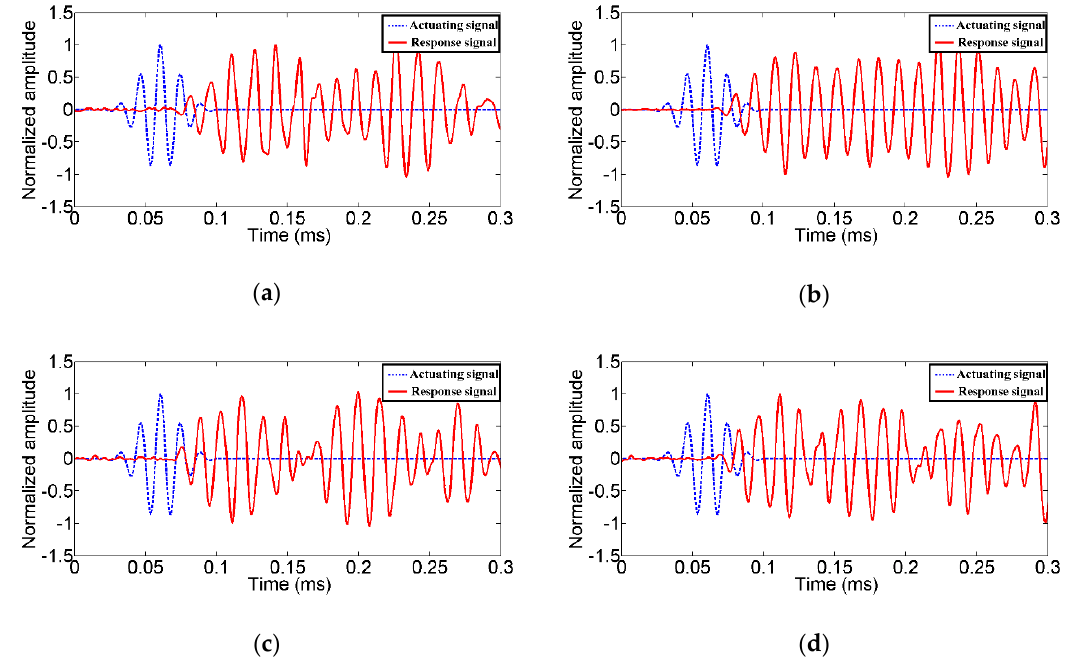
Figure 9. The time of arrival analysis when the TSA works as a sensor and ( a ) SA1 works as an actuator, ( b ) SA2 works as an actuator, ( c ) SA3 works as an actuator, ( d ) SA4 works as an actuator.